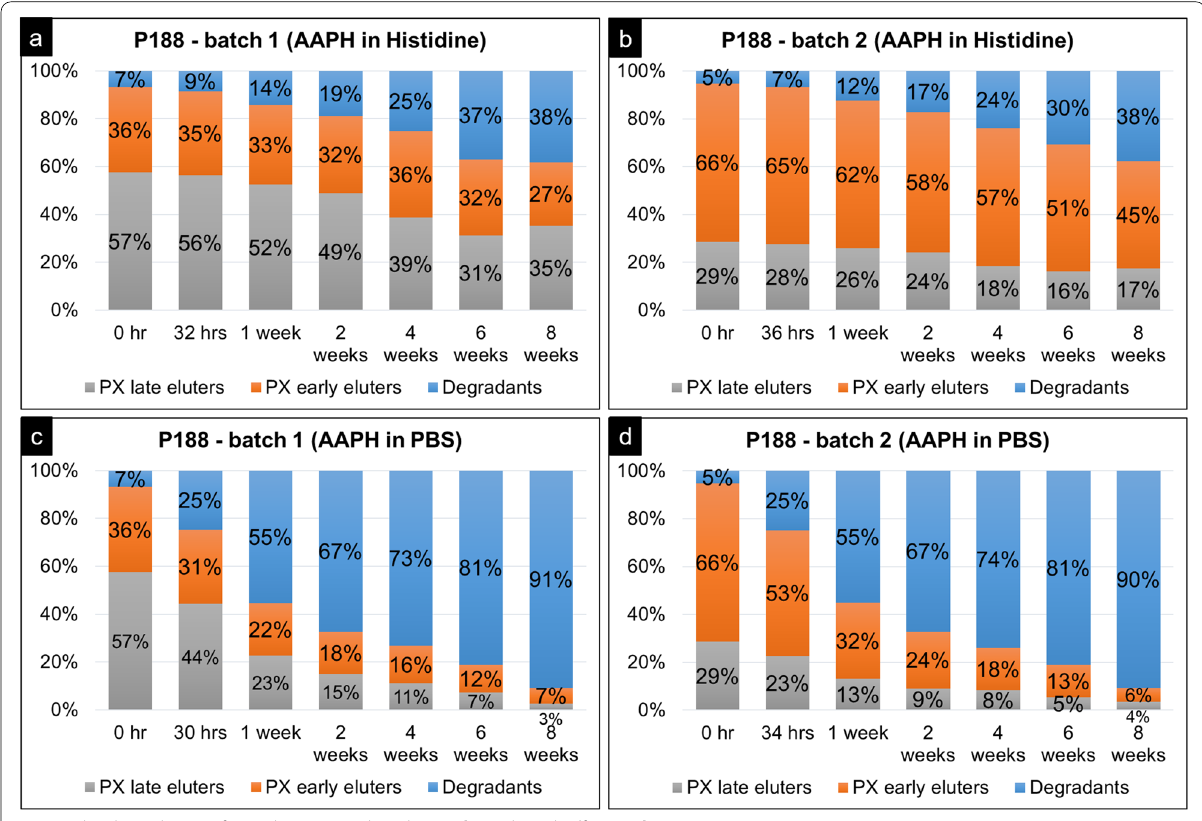
Fig. 4 The degradation of P188 by AAPH in histidine ( a , b ) and PBS buffers ( c , d